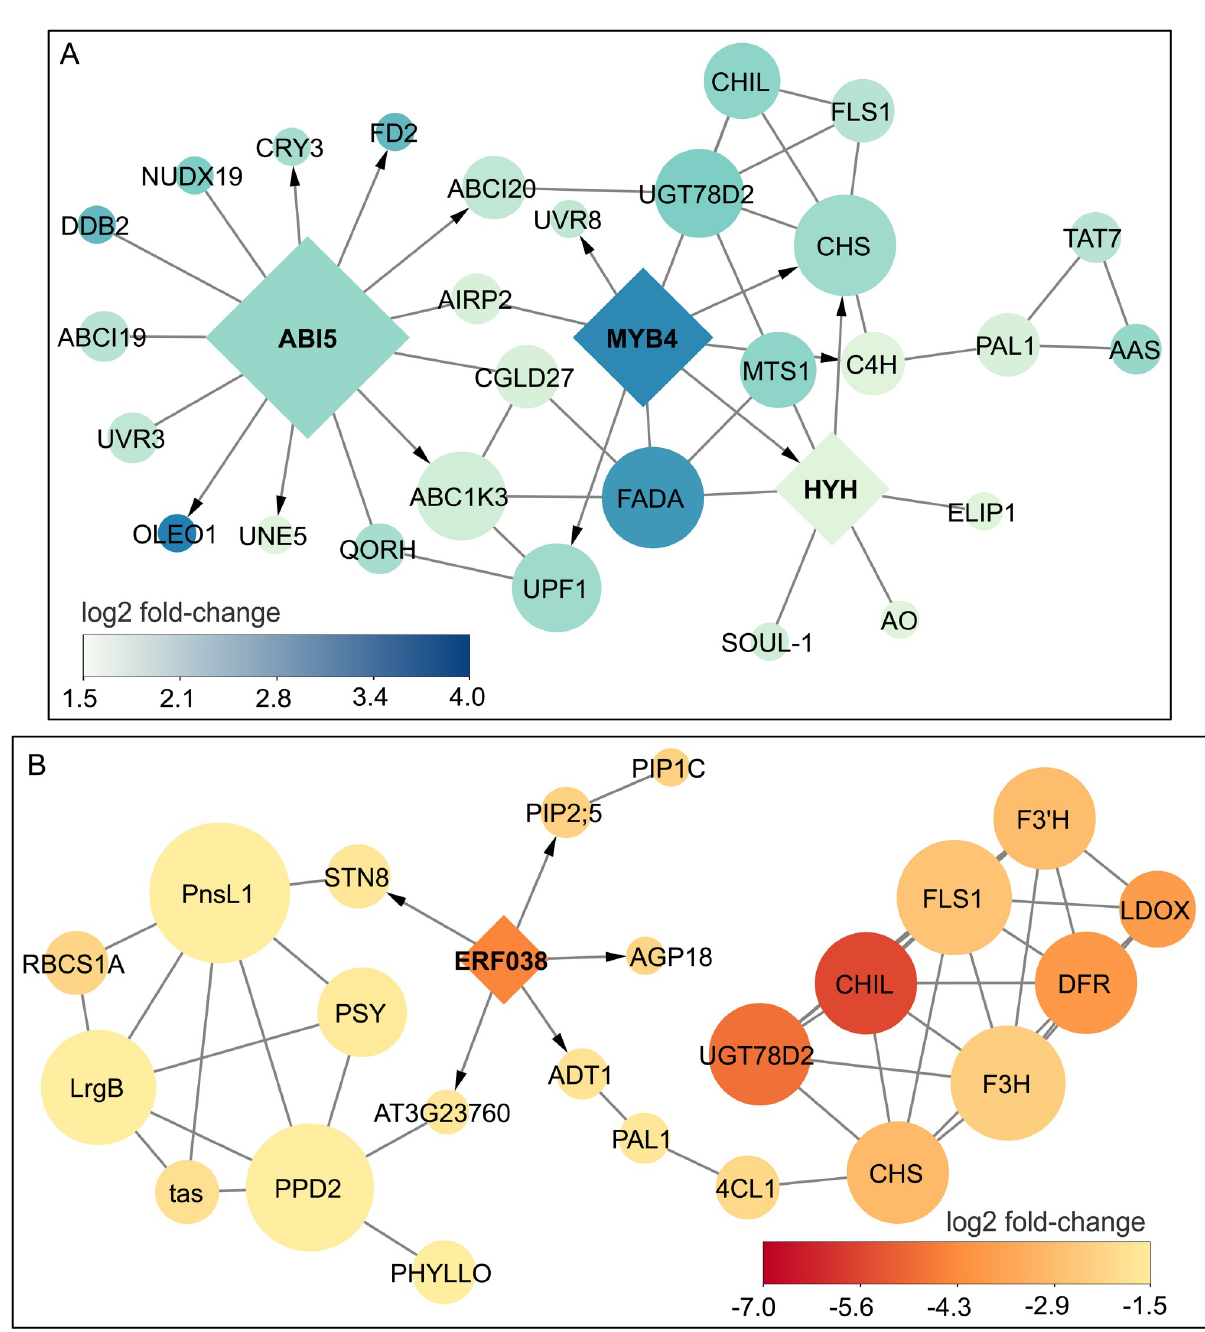
Fig 5. The networks of the DEG-encoded proteins. The network of the proteins encoded by the DEGs (A) under blue and (B) red light are shown. The regulation relationships are shown by directed edges connecting TF nodes (diamond shape) to target gene nodes (circle shape). The co-expression relationships are represented by undirected edges between non-transcription factor nodes. The size of a node is proportional to the number of edges that connect to that node. The full lists of genes are in S4 Table.